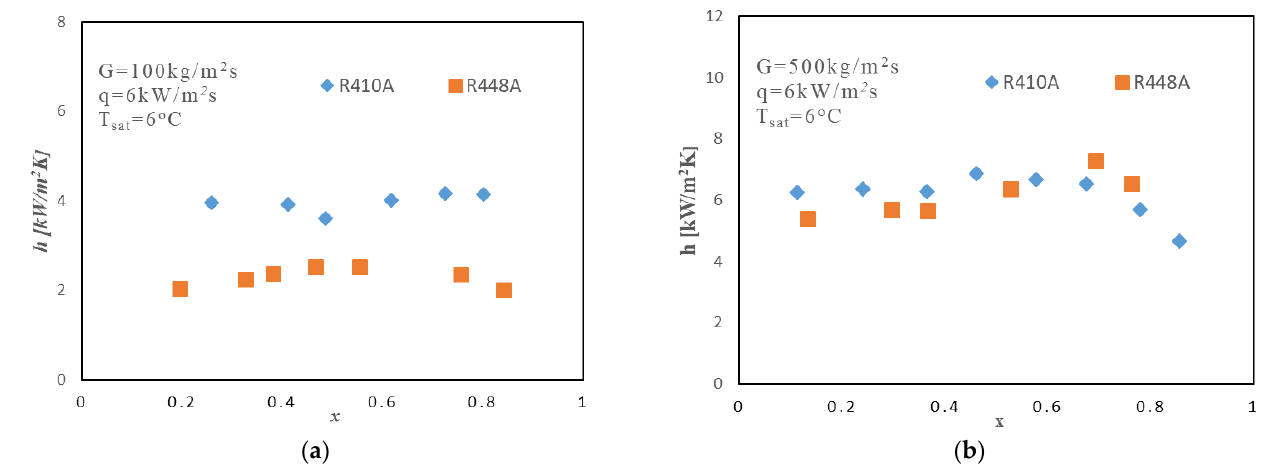
Figure 6. Comparison between the heat transfer coefficient of R448A and R410A under ( a ) low mass flux condition and ( b ) high mass flux conditions (b).